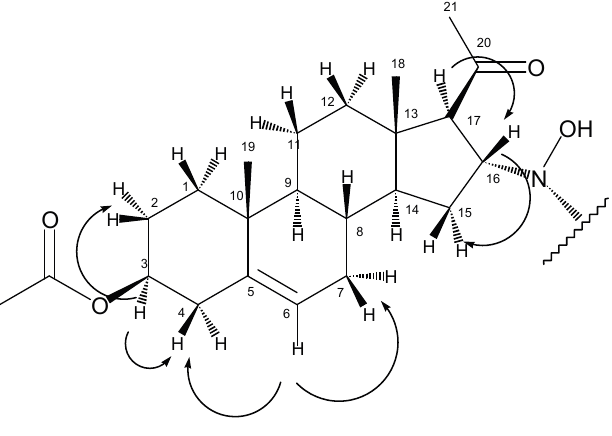
Figure 1. Coupled 1 H nuclei of 3 observed in the COSY experiment.